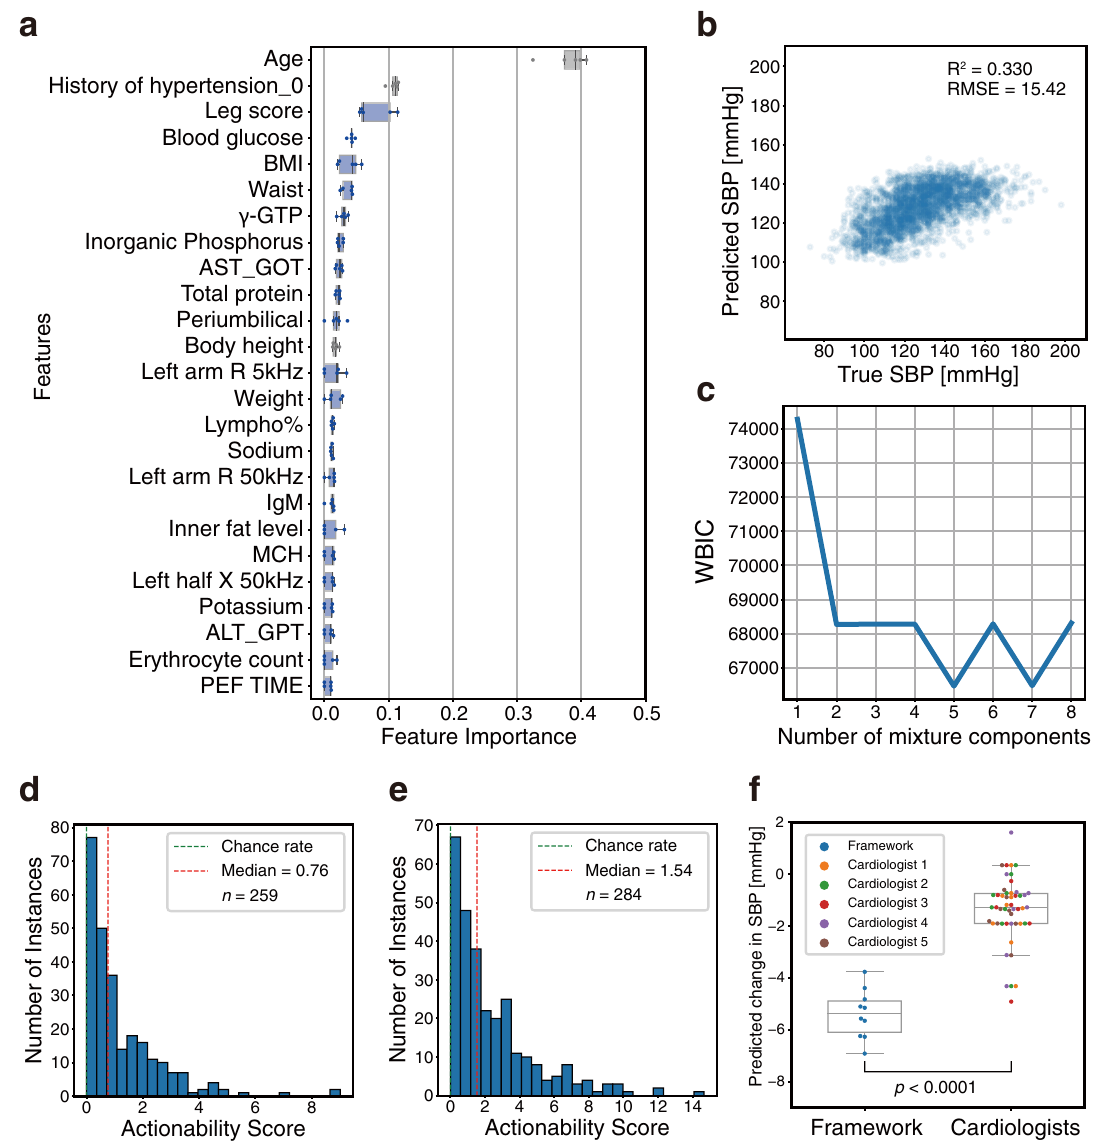
Fig. 5 Application of proposed framework on systolic blood pressure (SBP) regression task using the Iwaki health promotion project (IHPP) dataset. a Feature importance: these 25 features were selected by recursive feature elimination (RFE) to predict the SBP. RFE was performed with fi vefold cross- validation, and the feature importance when 25 variables remained is shown for each fold ( n = 5). The plot color represents the following: gray: variables which cannot be intervened, and blue: intervenable variables. Details of features are described in Supplementary Data 1. b Plot for prediction vs. true response variable. c Widely applicable Bayesian information criterion (WBIC) values of stochastic surrogate models with 1 – 8 mixture components. d , e Histogram of actionability scores with intervention variables based on data-driven selection ( d ) or hypothesis-driven selection ( e ) at different instances. An actionability score of zero indicates that the actionability of the optimal path is equivalent to that of the baseline path. f Comparison of predicted SBP reduction between framework-proposed paths and cardiologist-selected paths. Health improvement paths constructed based on hypothesis-driven intervention variables using our framework were compared with the cardiologist-selected paths among framework-proposed paths and random paths. Each cardiologist evaluated the same randomly selected instances ( n = 10). Statistical signi fi cance was calculated using the Welch ’ s t -test (two-sided). In box- plot, center line represents median; box limits, upper and lower quartiles; whiskers, 1.5× interquartile